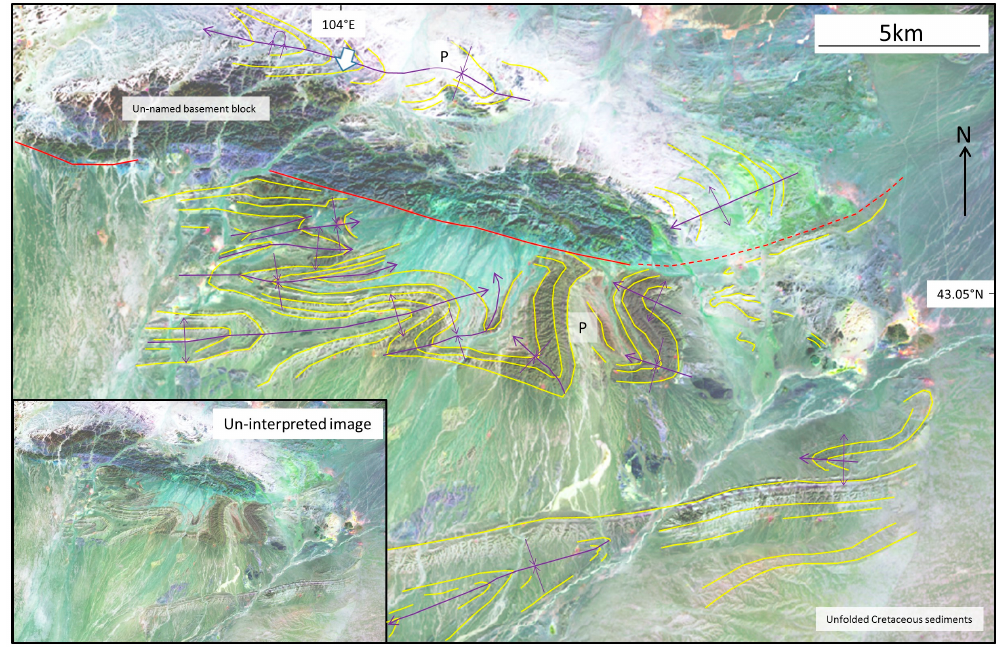
Figure 9. Landsat TM image (4-2-5 false-color scene processed using ArcMap, ESRI, Redlands, CA, USA, 2015) showing bedding traces (yellow lines) and major fold hinges in refolded Permian (P) sedimentary succession south of Khurmen, southernmost Mongolia. Thick white arrow indicates direction of fold vergence. Inset shows un-interpreted scene. See Figure 1 for location.